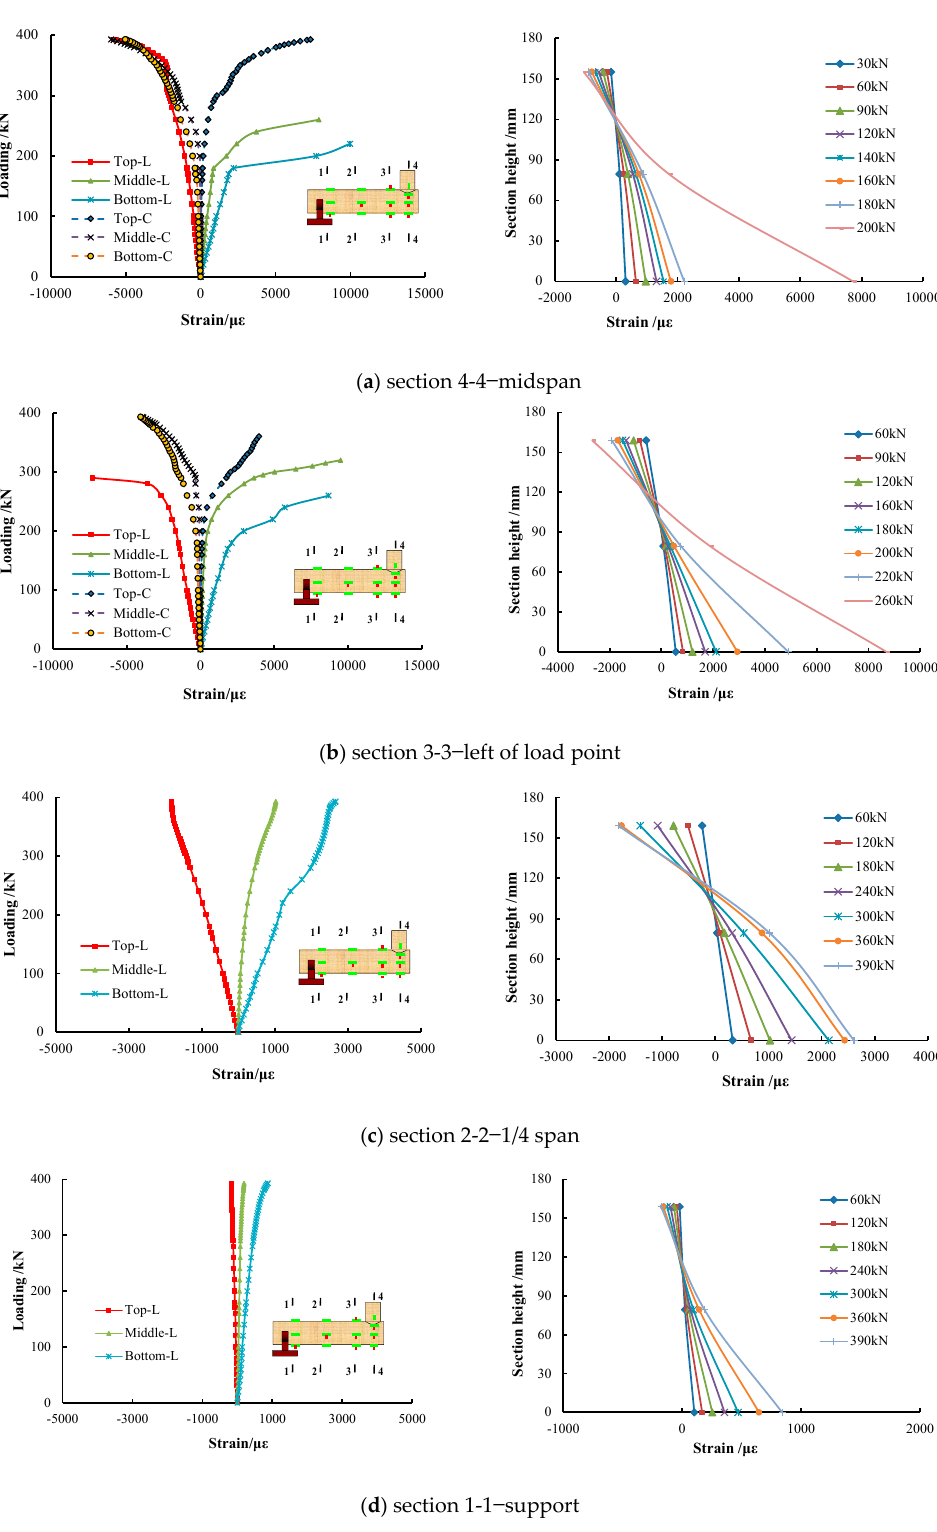
Figure 11. Strain development law of the section of W5-C100-2.